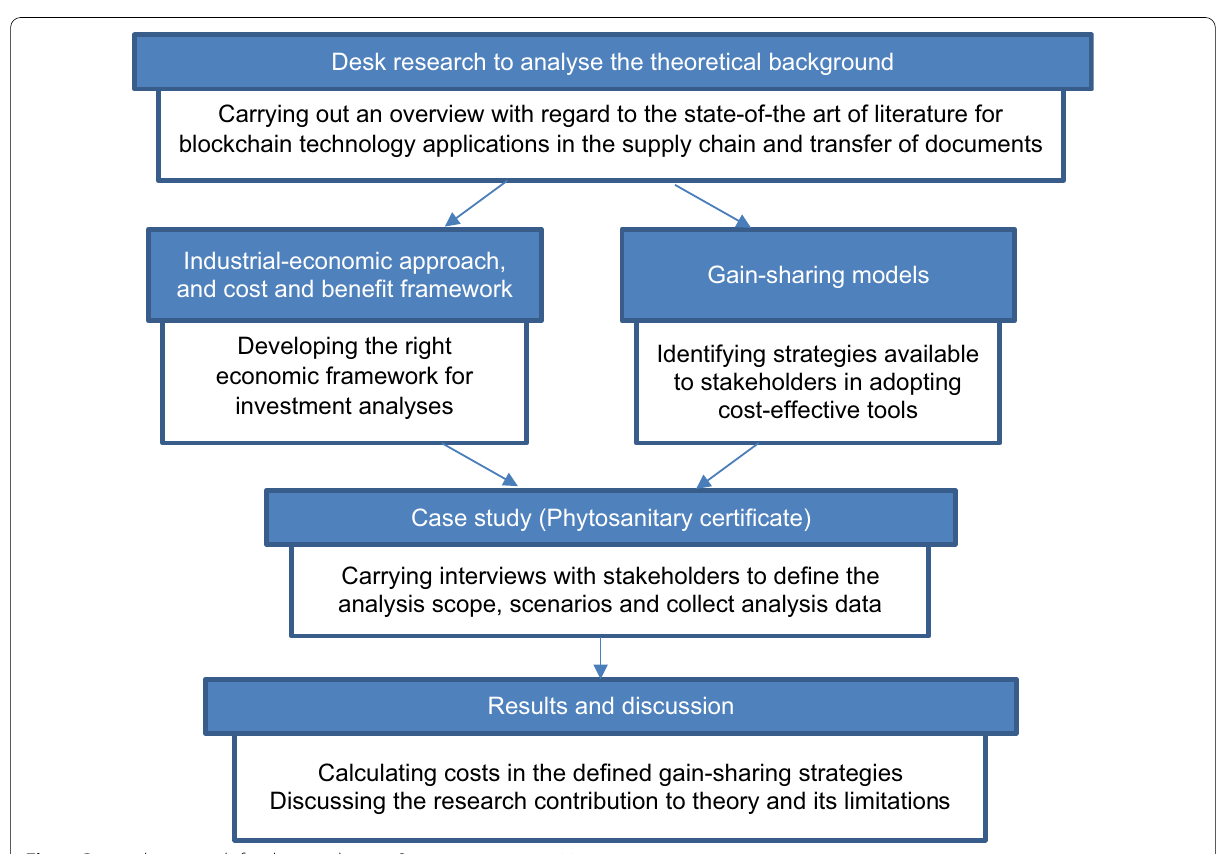
Fig. 1 Research approach fundamental steps. Source : own